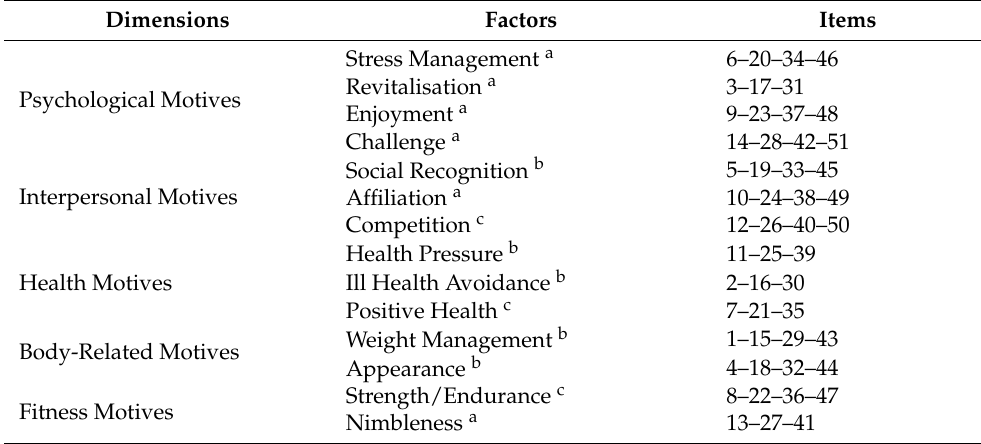
Table 1. Motivational dimensions and factors of the Exercise Inventory Motivation 2 (EMI-2).